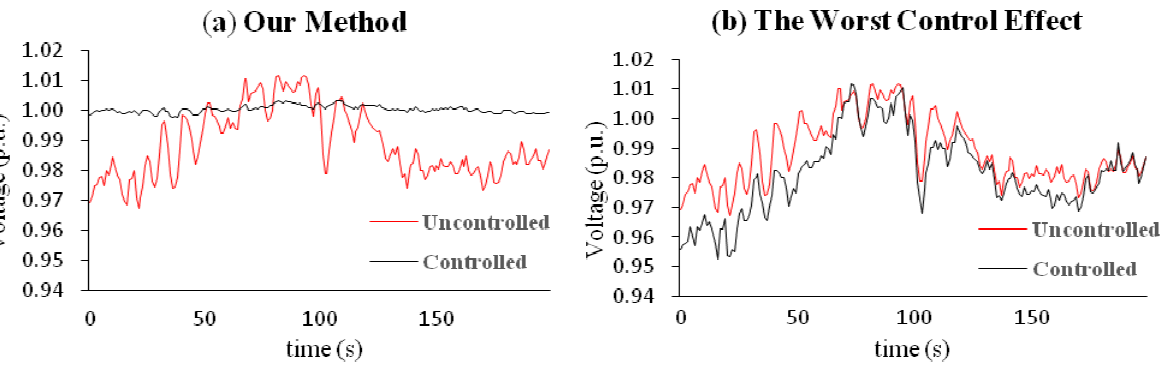
Figure 7. Voltage deviation using the AVC with different pilot node selection schemes: ( a ) our method; ( b ) worst node selection.